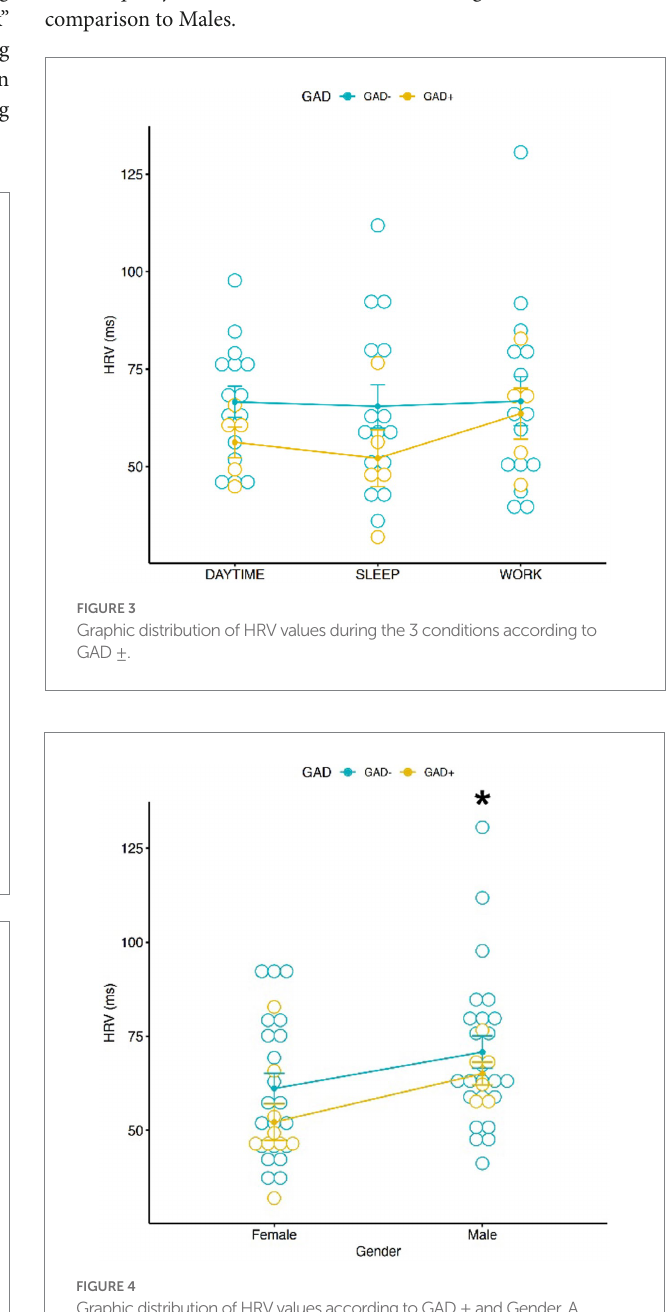
FIGURE 4 Graphic distribution of HRV values according to GAD ± and Gender. A significant different HRV value according to Gender was found. No significant interaction was found between Gender, HRV and GAD±. * = p < 0.05.